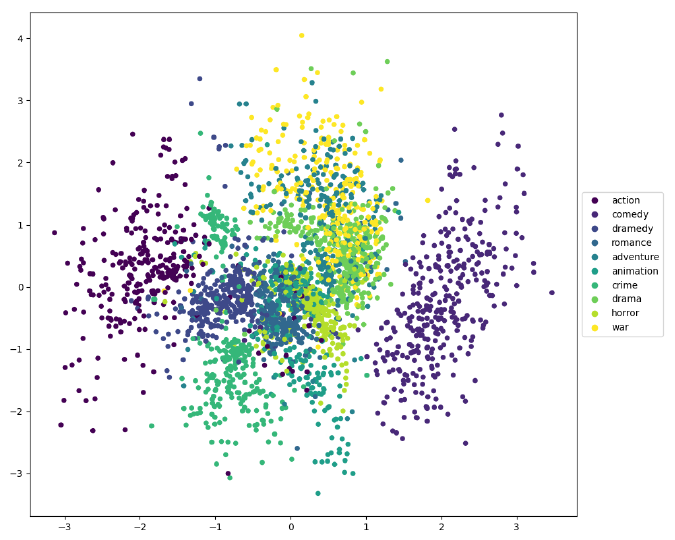
Figure 2. Second and third components of the principal component analysis (PCA) on variational autoencoder (VAE).